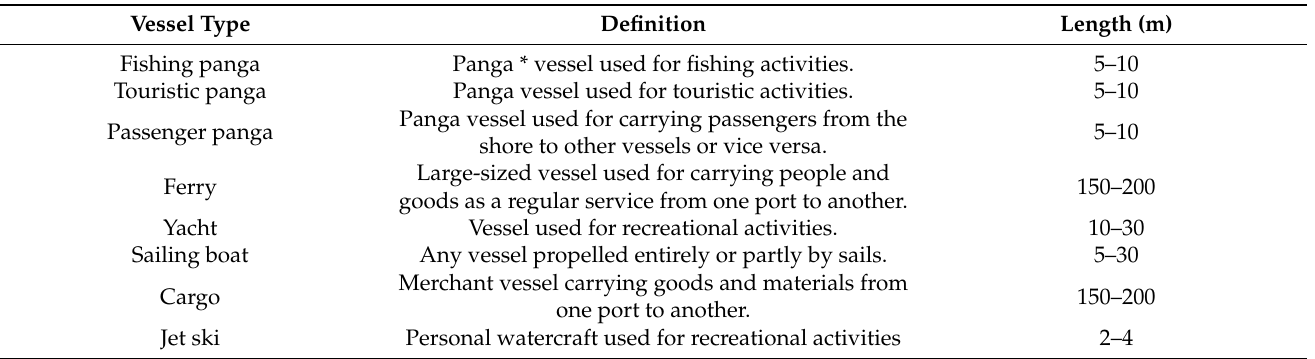
Table 1. Vessel types considered in the